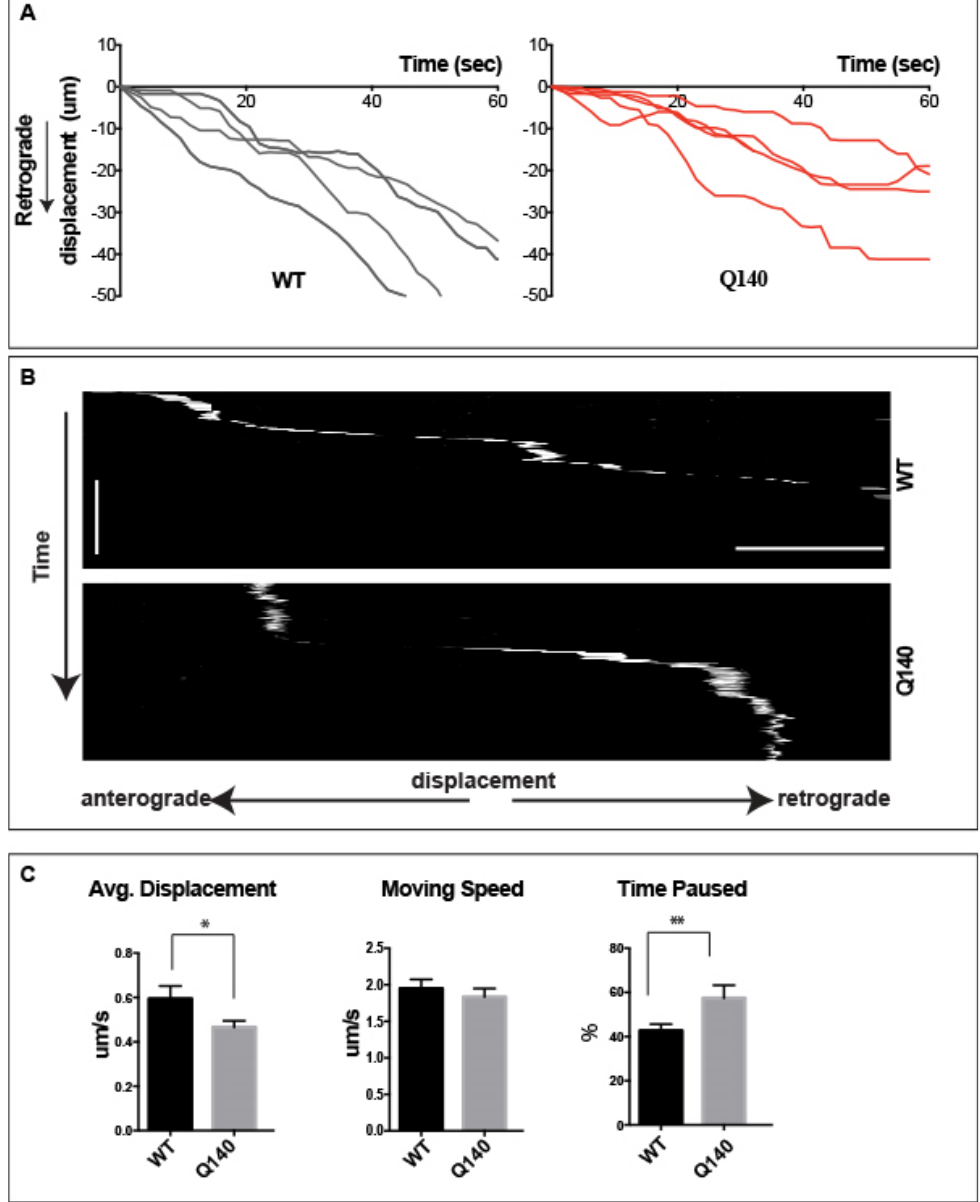
Figure 5. Increased pause time of QD-BDNF endosome in Q140 striatal dendrites. ( A ). Displacement vs. time plots of QD-BDNF retrograde transport in dendrites of WT (gray) and Q140 (red) MSNs. 4 from 50 samples represent. ( B ). Kymographs detailing single-molecule QD labeled endosome dendritic transport. ( C ). Bar graphs quantifying averaged displacement, moving speed and percentage of time paused for QD-BDNF in WT and Q140 MSN dendrites. Data were from three individual repeats. Vertical Scale bar = 1 min., horizontal scale bar = 5 µm, * p < 0.01, ** p < 0.05.